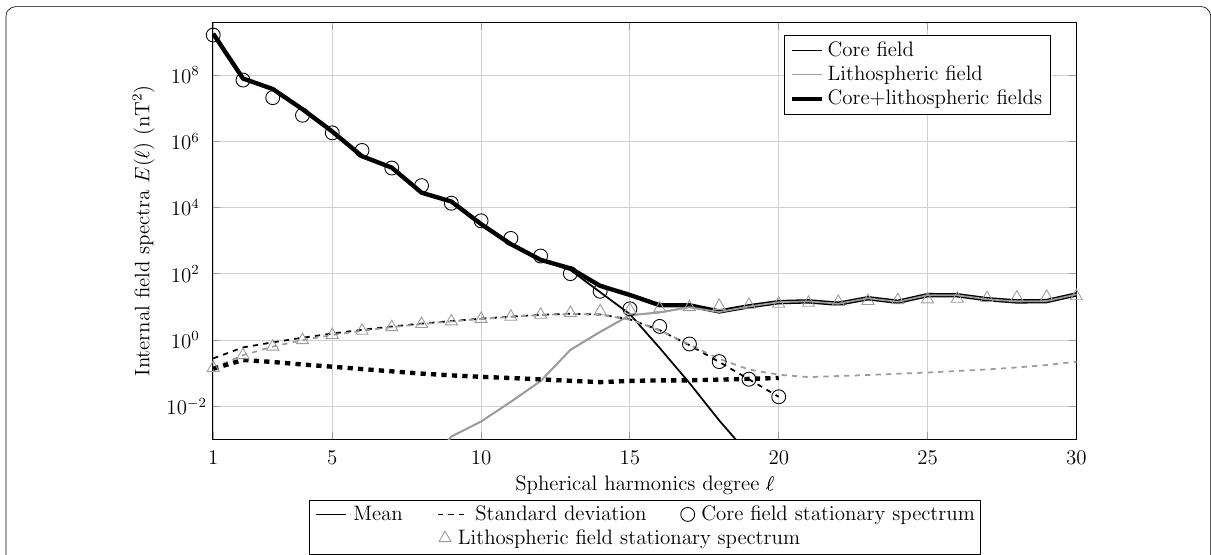
Fig. 2 Energy spectra at the Earth’s surface in 2015.0 of the mean (continuous lines) standard deviation (dashed lines) and initial prior standard deviation (symbols) associated with the core field (thin black lines and symbols), the lithospheric field (gray lines and symbols) and the sum of the core and lithospheric fields (thick black